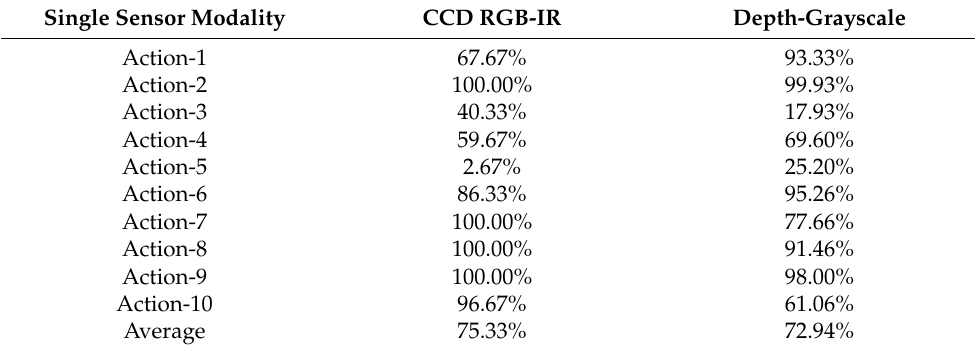
Table 3. Recognition performances of hand gesture intention recognition by typical deep learning of the VGG-16 CNN with only a single modality of CCD RGB-IR or depth-grayscale images on the recognition system test.